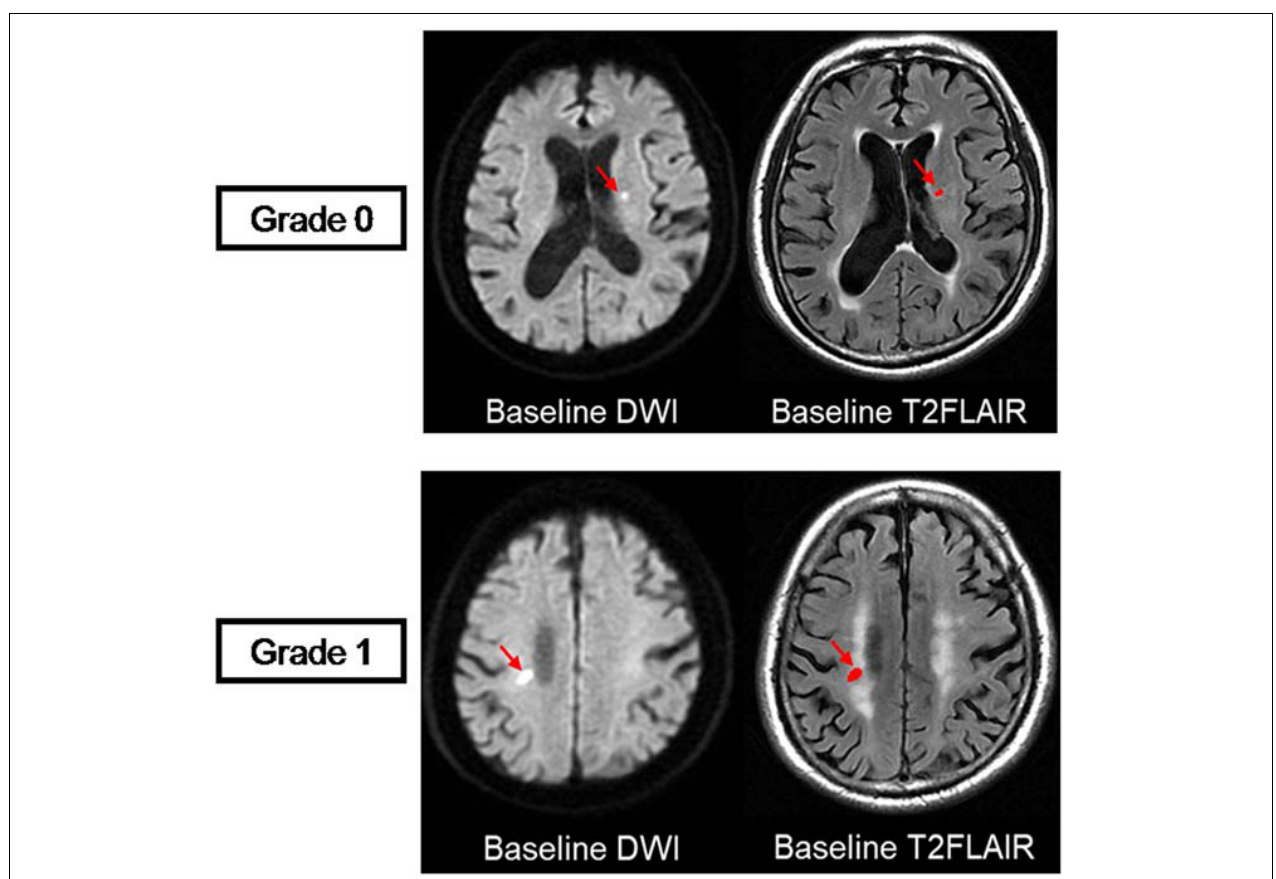
FIGURE 3 | Visual rating scale. Spatial relationship between RSSIs and surrounding white matter hyperintensities are rated at baseline. The top row shows an RSSI on baseline T2 FLAIR (red arrow) isolated from the surrounding WMH, which is rated as grade 0. The bottom row shows an RSSI on baseline T2 FLAIR (red arrow) contacting with the surrounding WMH, which is rated as grade